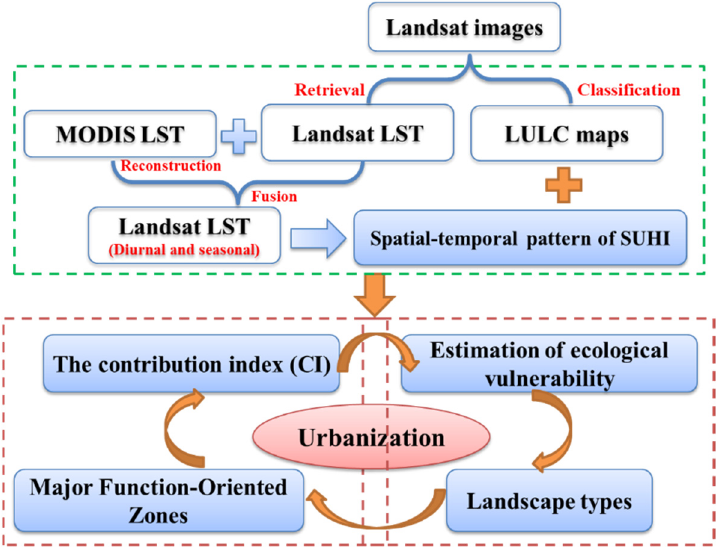
Figure 2. Flow chart of the research